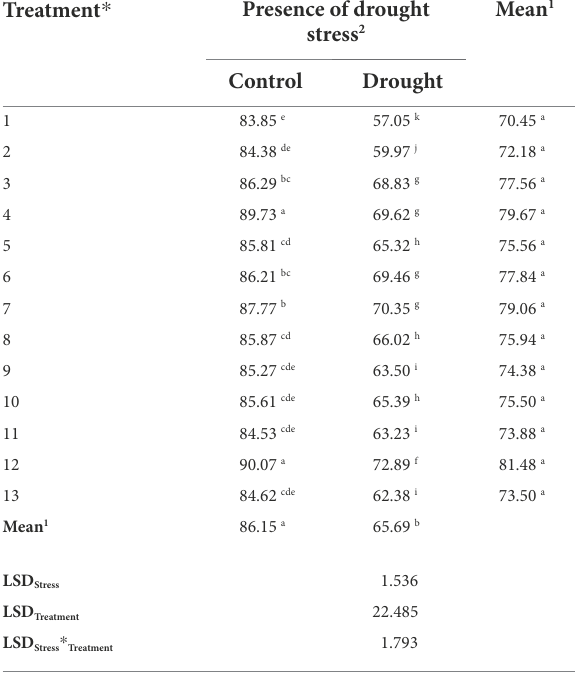
TABLE 3 The influence of the seed treatment and drought stress on relative water content – RWC (%) during drought stress. Treatment